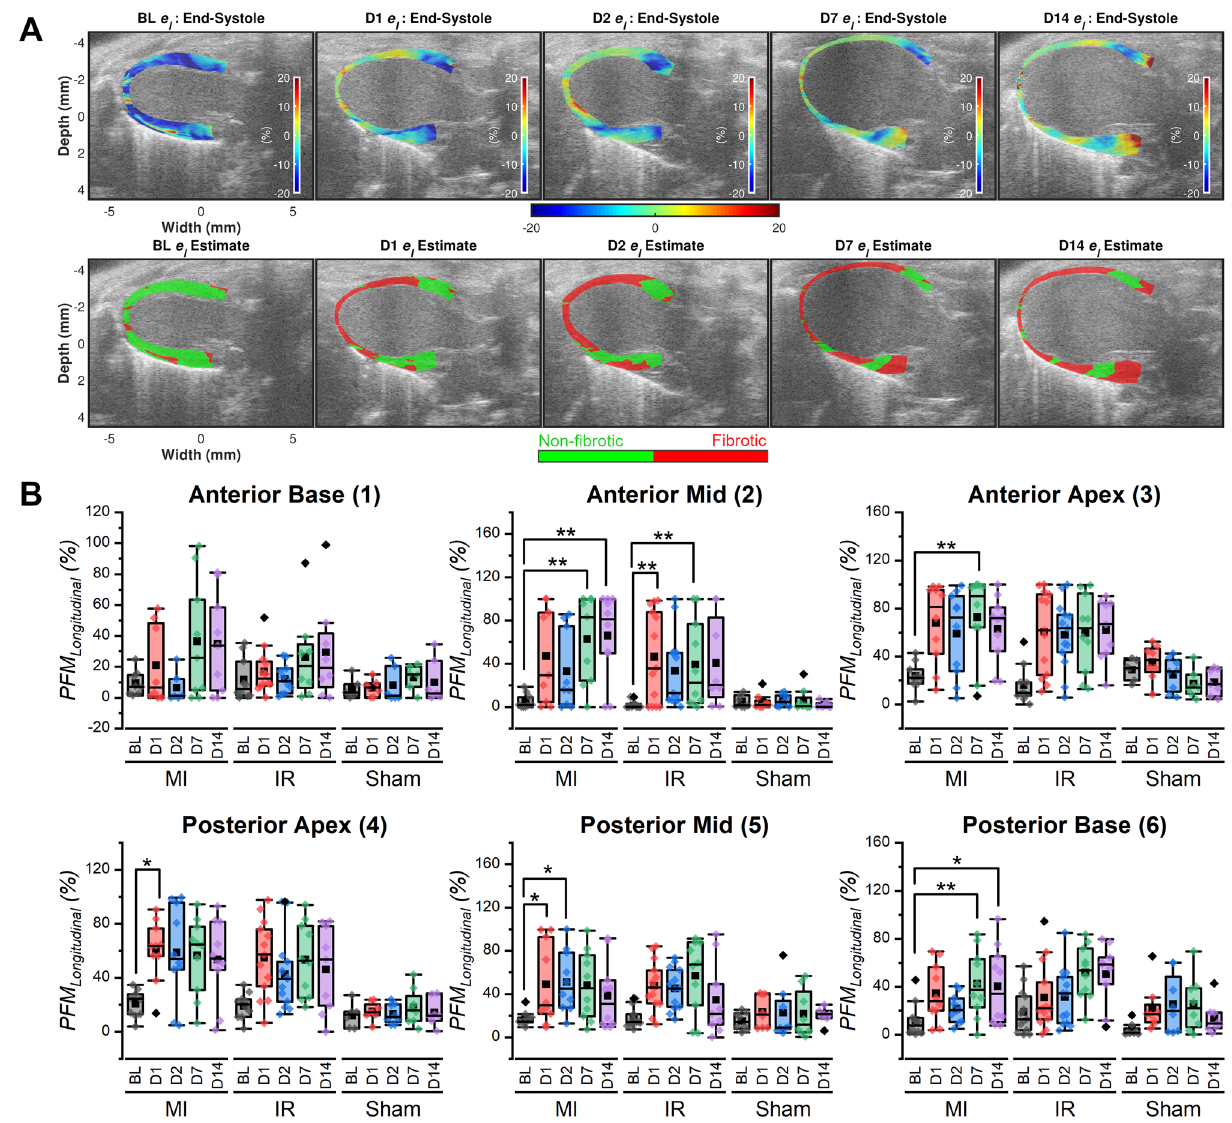
Figure 3. Monitoring cardiac remodeling using ES longitudinal strain images. ( A ) Top row: Temporal progression of ES longitudinal strain images from BL to Day 14 (D14) in a female BALB/CJ mouse after MI surgery. Strain display dynamic range is from − 20 to + 20%. Negative strain value (blue) = myocardial wall shortening, positive strain value (red) = myocardial wall elongation and zero strain value (light green) = no wall motion. Bottom row: Cardiac fibrosis maps estimated using the ES longitudinal strain images presented on the top row. Red = fibrotic region, green = non-fibrotic region. ( B ) Top row: Box and whisker plots demonstrating temporal variation and inter-group comparison [MI (n = 10), IR (n = 13) and Sham (n = 8)] of PFM estimated from longitudinal strain ( PFM Longitudinal ) in the anterior myocardial segments. Bottom row: Box and whisker plots demonstrating temporal variation and inter-group comparison (MI, IR and Sham) of PFM Longitudinal in the posterior myocardial segments. Friedman’s test with Bonferroni–Dunn post hoc test was used. Symbol definitions: BL—Baseline, D1—Day 1, D2—Day 2, D7—Day 7, D14—Day 14, Squares—mean, Diamonds— outliers, whiskers—1.5 × IQR (Inter-quartile range), box—25th to 75th percentiles, * p < 0.05, ** p < 0.01, *** p < S5 respectively. For the MI group, PFM Radial (%) values at the posterior basal segments did not differ significantly between BL and D14 (p = 0.237, Supplementary Table S2) while corresponding PFM Longitudinal (%) values showed a significant difference (p = 0.011, Supplementary Table S5). Thinning of the apical wall (Fig. 4C) with the pres- ence of collagen fibers (observe blue staining in the magnified region presented in Fig. 4D) were seen in the MT stained histopathology WSI. The corresponding classified image confirms that the region of fibrosis is primarily located in the apical segments with an extension into the mid segments (Fig. 4C,D). These results demonstrate that the radial strain fibrosis map has better qualitative agreement with the ground truth fibrosis map compared to the longitudinal strain fibrosis map. A similar result was observed for a mouse with smaller MI (Supplemen-